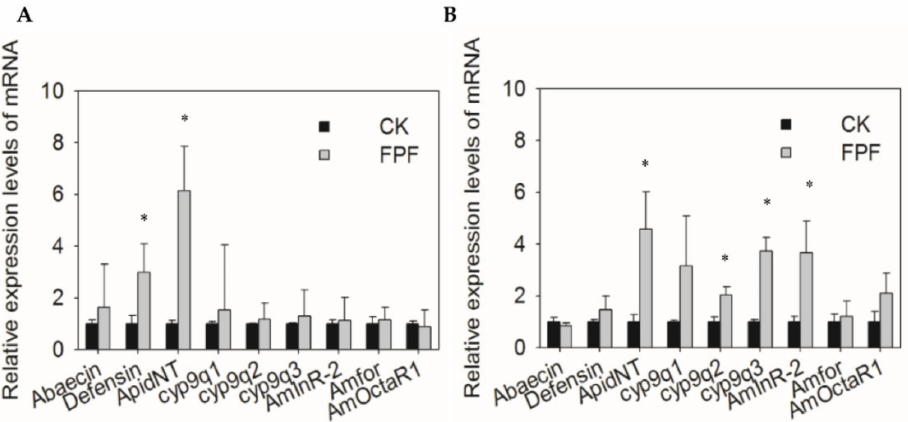
Figure 4. Effects of FPF on the relative expression levels of genes in newly emerged bees ( A ) and forager bees ( B ). Using four colonies run three replicates. Ten bees were randomly selected and pooled together as one biological replicate sample for gene expression analysis. Expression levels were normalized to Actin and then to the gene expression level of the CK. Values represent mean ± SEM ( n = 4). Significant differences between FPF treatment and CK were analyzed by one-way ANOVA (* p <